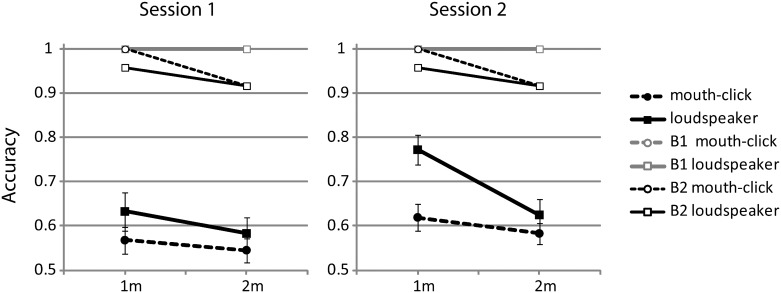
Data for B1 and B2 plotted in comparison to data from sighted participants split by session, distance and sound (i.e. data replotted as from Fig 3).Note that the plot for B1 has two results superimposed. For results of significance tests between sighted participants and B1 and B2 please see Table 2.